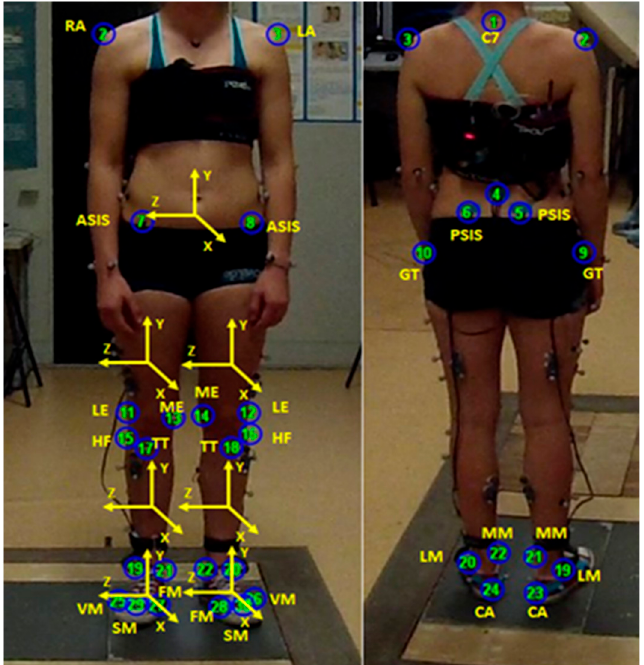
Figure A5. Anatomical landmarks position and anatomical reference frames for the pelvis, thigh, shank.